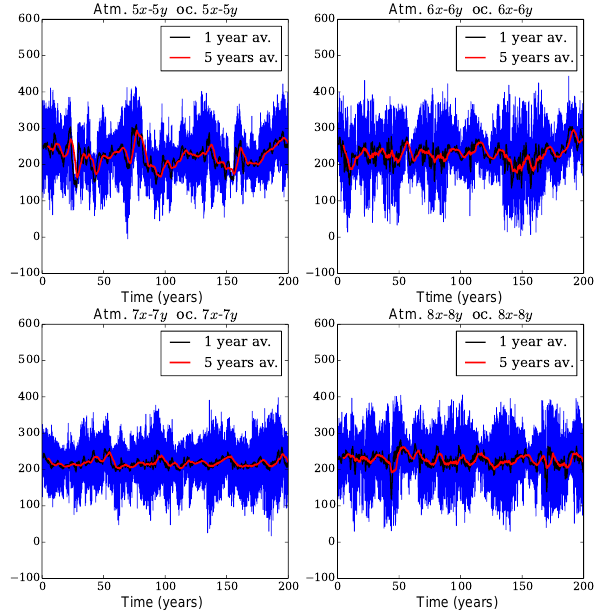
Figure 8. Time series of the geopotential height difference (contin- ued from Fig. 7).